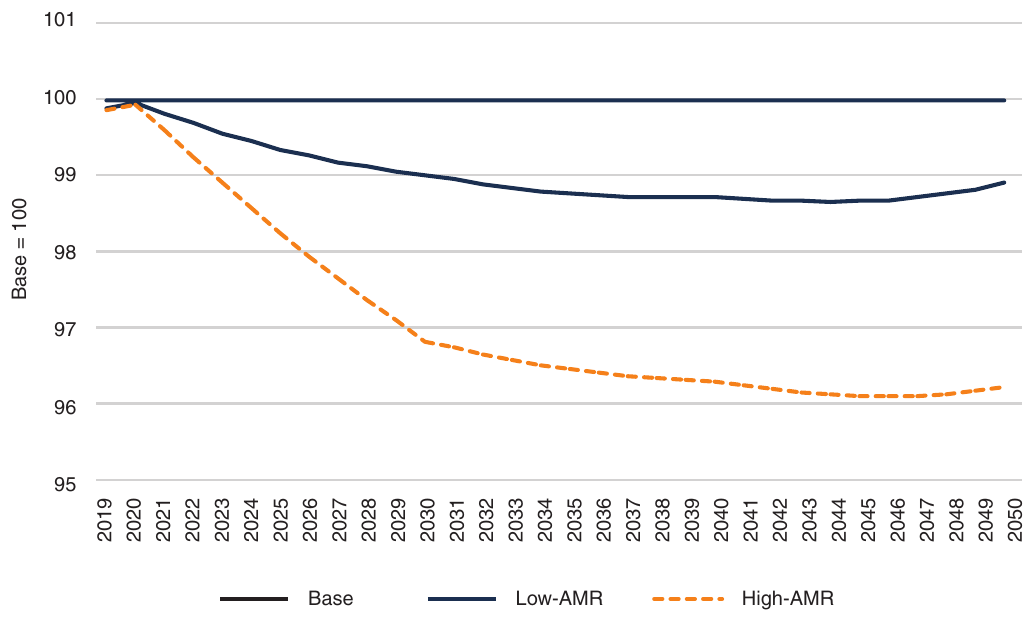
FIGURE ES2. Economic Costs of AMR May Be as Severe as During the Financial Crisis AMR could reduce GDP substantially—but unlike in the recent financial crisis, the damage could last longer and affect low-income countries the most (annual costs as % of GDP)